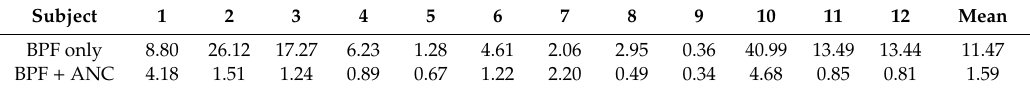
Table 1. Results of HR AAE with and without the cascaded adaptive noise cancellation (ANC) stage.